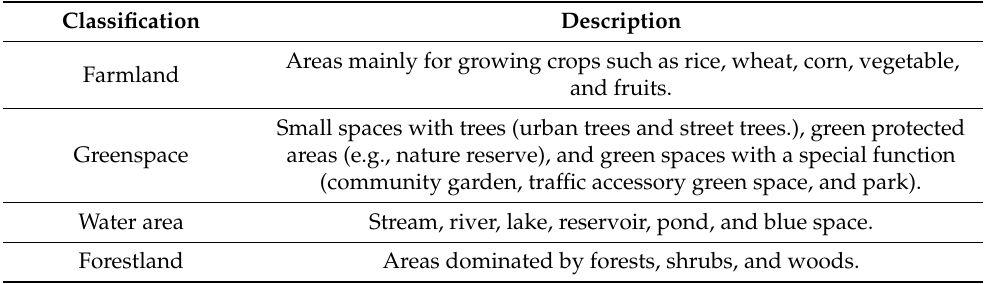
Table 1. Green infrastructure (GI) classification and description used in this research. Classification Description Areas mainly for growing crops such as rice, wheat, corn, vegetable, Farmland and fruits. Small spaces with trees (urban trees and street trees.), green protected Greenspace areas (e.g., nature reserve), and green spaces with a special function (community garden, traffic accessory green space, and park). Water area Stream, river, lake, reservoir, pond, and blue space. Forestland Areas dominated by forests, shrubs, and